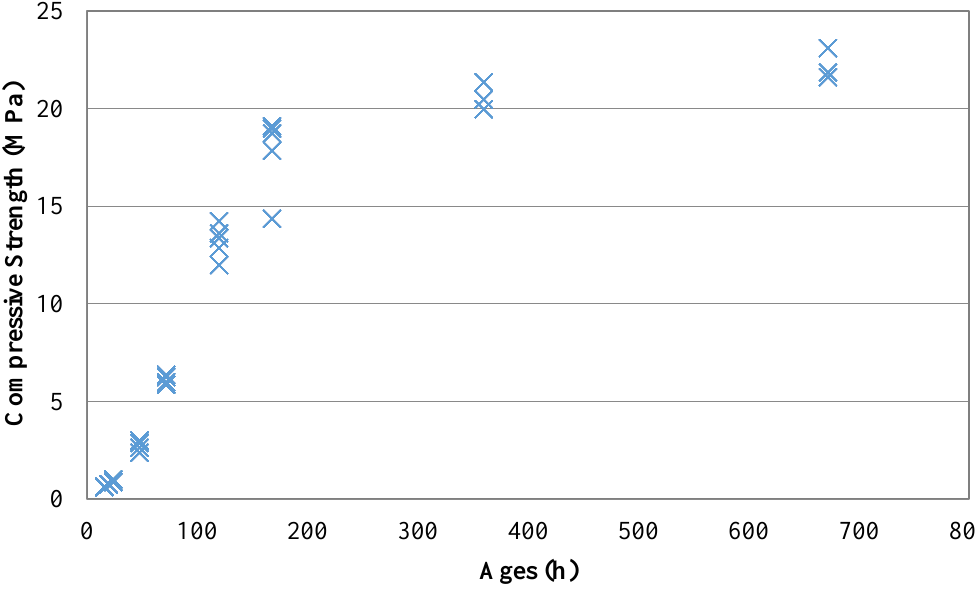
Figure 6. Relationship of ultrasonic pulse velocity and compressive strength (24 MPa).